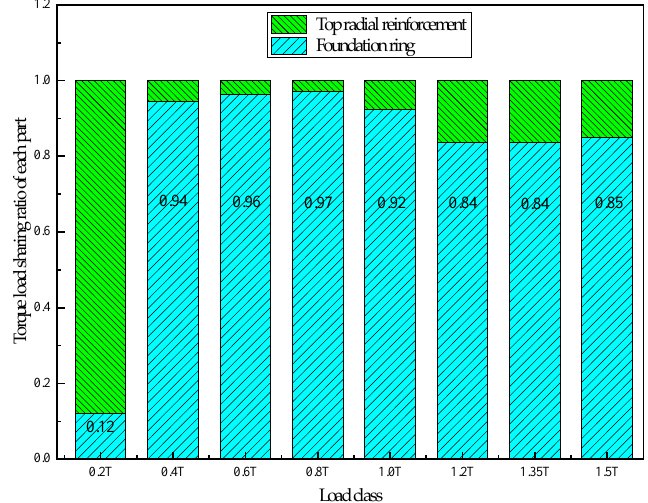
Figure 9. Torque load sharing ratios of ZT-1.